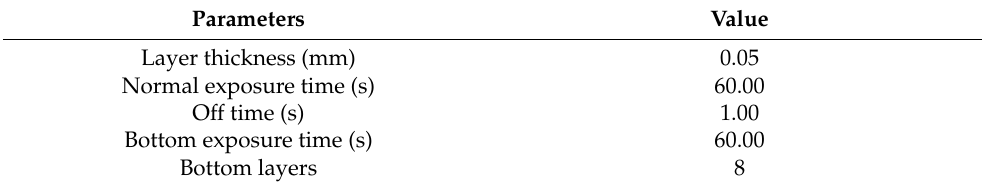
Table A1. The optimized parameter settings for PHB/UDMA resin blends.